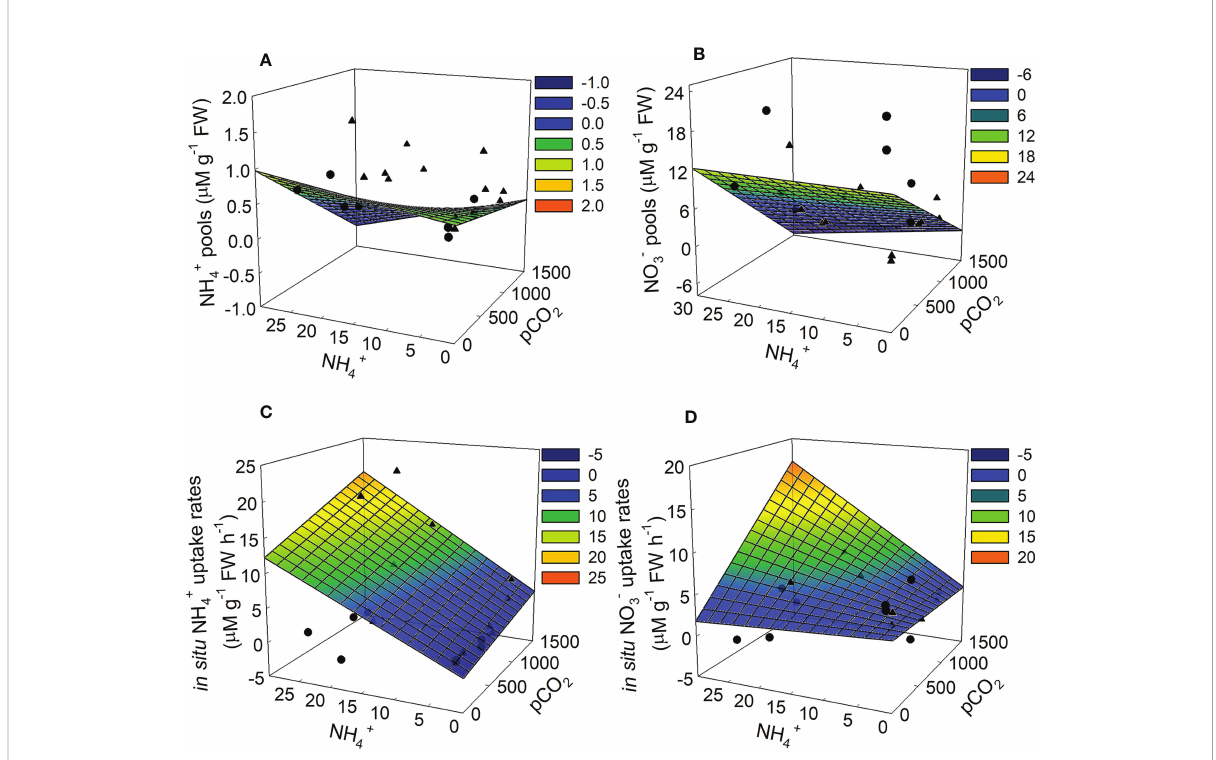
FIGURE 5 Modeled physiological responses for Ulva lactuca based on responses to pCO 2 and NH 4+ treatments in laboratory experiments. (A) NH 4+ pools (B) NO 3- pools rates (C) in situ NH 4+ uptake and (D) in situ NO 3- uptake rates. The linear expression y= b 0 +( b 1 *x 1 )+( b 2 *x 2 )+( b 3 *(x 1 *x 2 )), where x 1 = pCO 2 and x 2 = NH 4+ , was used to fi t model surface with conventional regression coef fi cients using weighted model-averaging (see Table 2). Overlaying the modeled mesh plots are the date from each trial where trial 1 is represented by circles and trial 2 is represented by